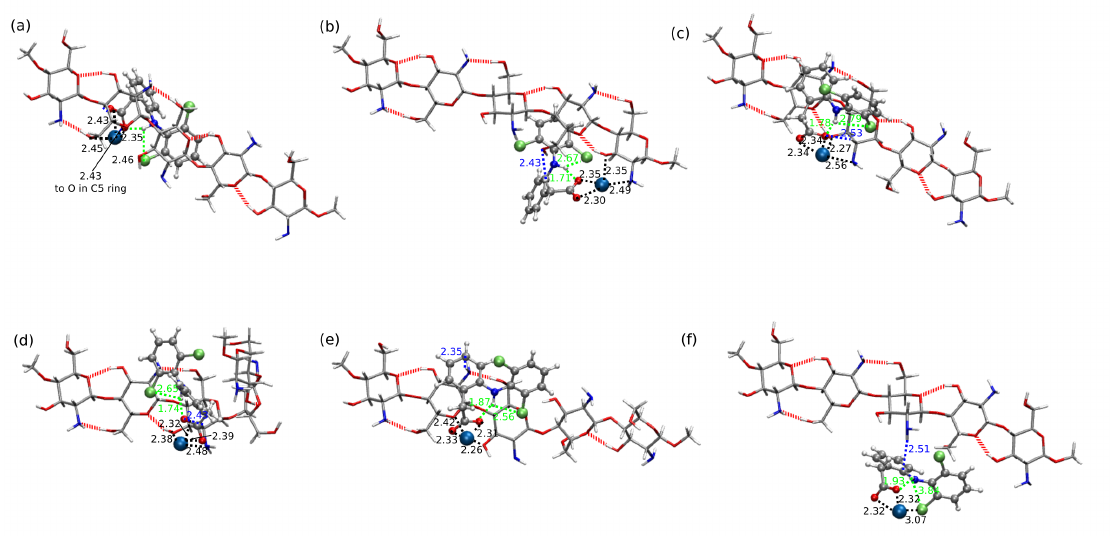
Figure 10. B97-D3/6-311++G(d,p) interaction in most attractive: ( a ) CS5:DFNa 8 , ( b ) CS5:DFNa 6 , ( c ) CS5:DFNa 10 , ( d ) CS5:DFNa 7 , ( e ) CS5:DFNa 2 and the weakest of all the analyzed CS5:DFNa complexes: ( f ) CS5:DFNa 3 . Blue dashed lines and labels present intramolecular hydrogen bond in diclofenac sodium, green dashed lines and labels: intermolecular hydrogen bonds, red dashed lines depict intramolecular hydrogen bonds in chitosan chain and black lines and labels: distances from sodium cation to its nearest neighbors. This convention is used further on.